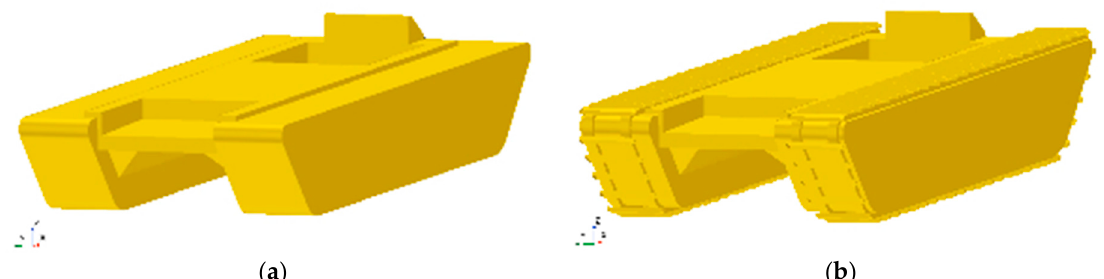
Figure 1. Geometric model of the vessels; ( a ) w/o caterpillar, ( b ) w/caterpillar.